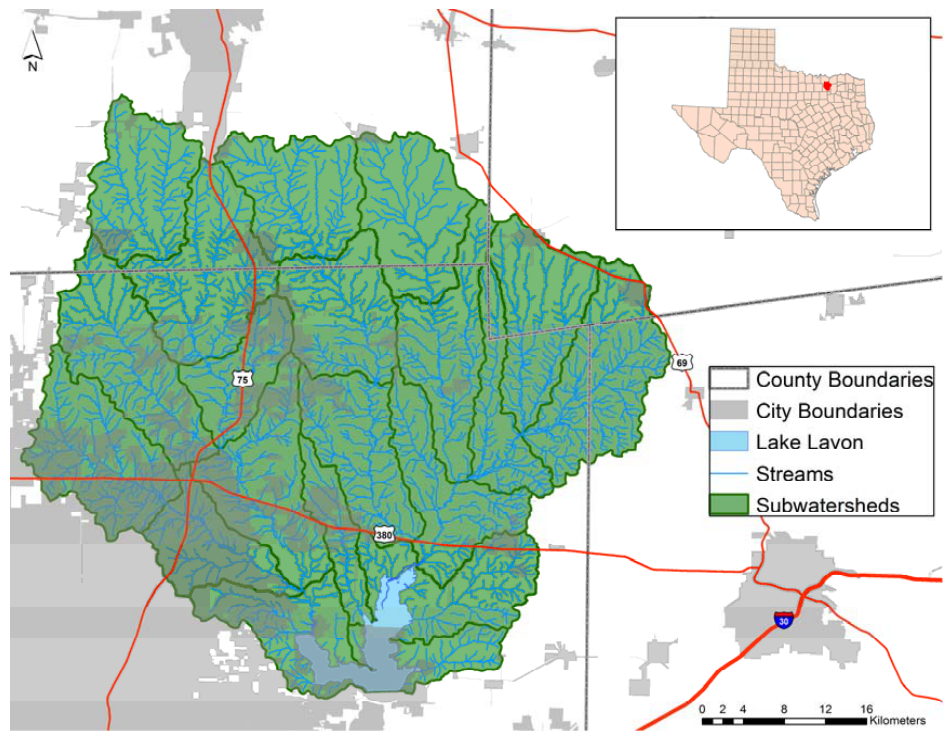
Figure 4. Location of Lavon Lake watershed with delineated subwatersheds and stream network.